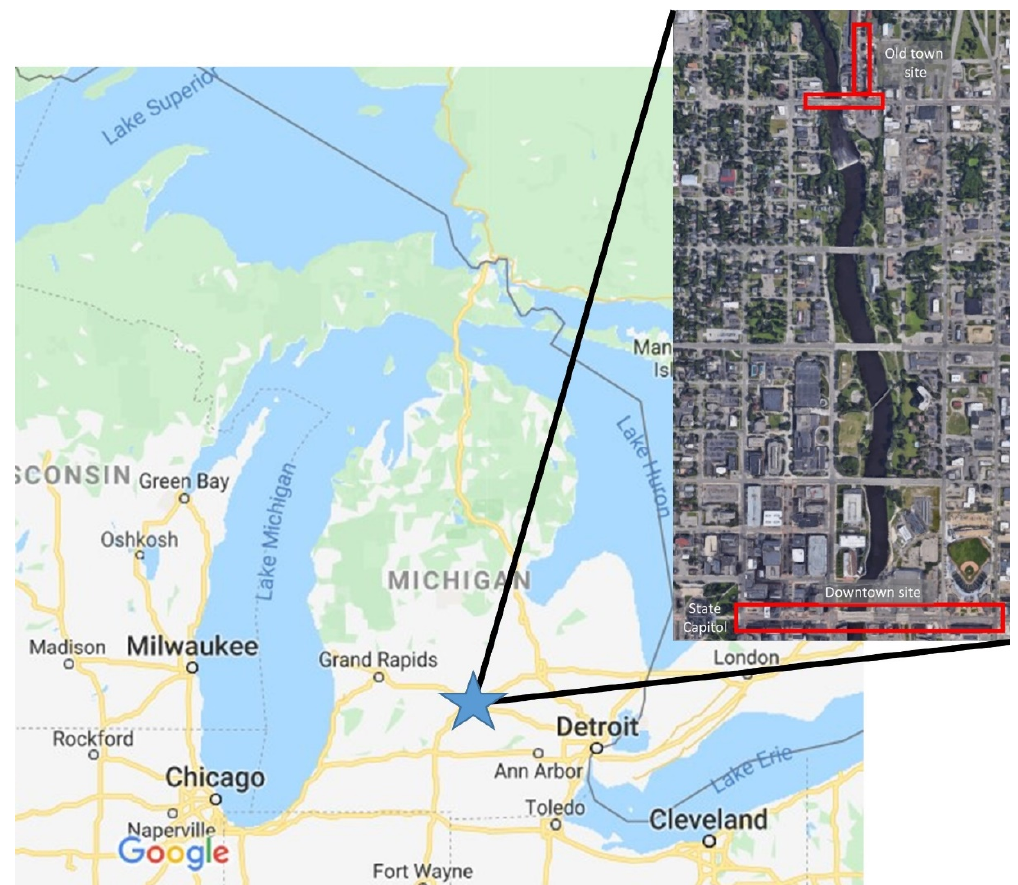
Figure 1. Location of field plots in Downtown and Old Town Lansing, MI, USA.